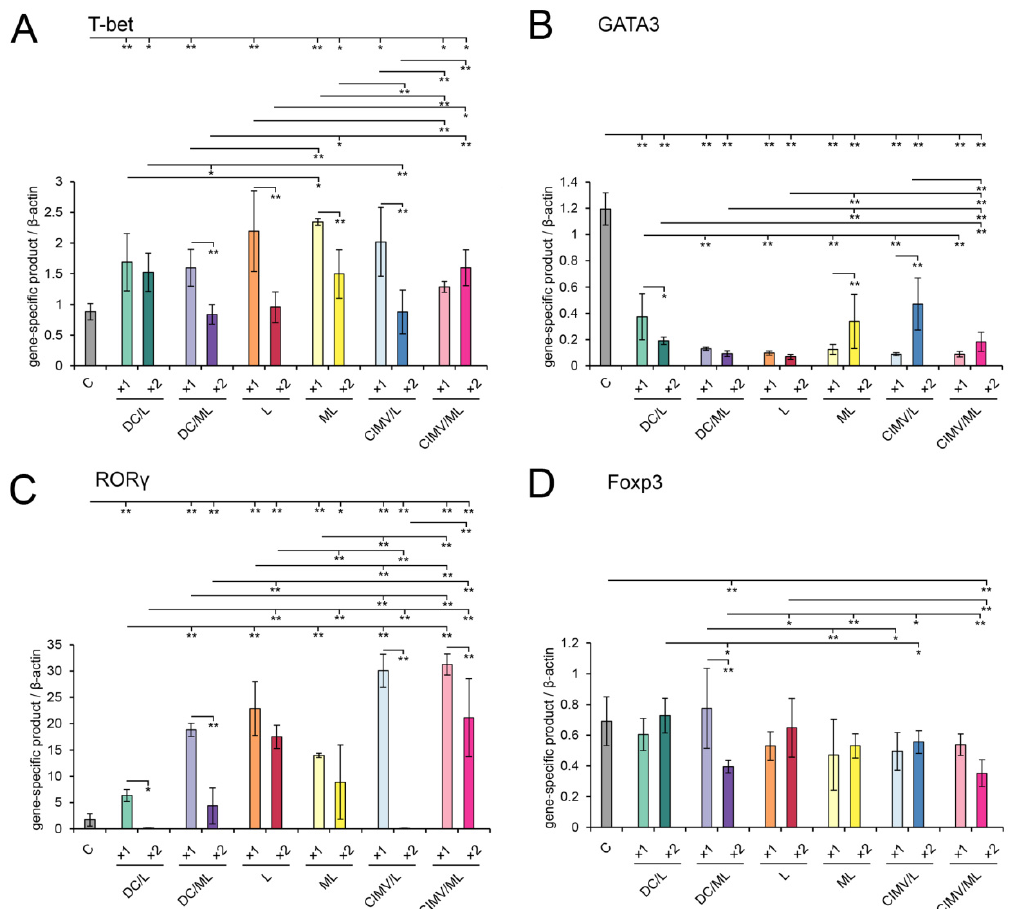
Figure 8. The expression levels of master regulators of T helper immune response ( A ) T-bet, ( B ) GATA3, ( C ) ROR γ , and ( D ) Foxp3 in splenocytes of RLS 40 -bearing mice treated with DC-, liposome-, and CIMV-based vaccines determined by qPCR and TaqMan probes. The expression level of gene-specific product was normalized to the expression level of β -actin. The expression levels of genes were presented on the 21st day after tumor transplantation. Data are presented as mean ± S.E.M. Data were statistically analyzed using one-way ANOVA with post-hoc Tukey test. Statistically reliable differences between the groups: * p < 0.05, ** p < 0.01.